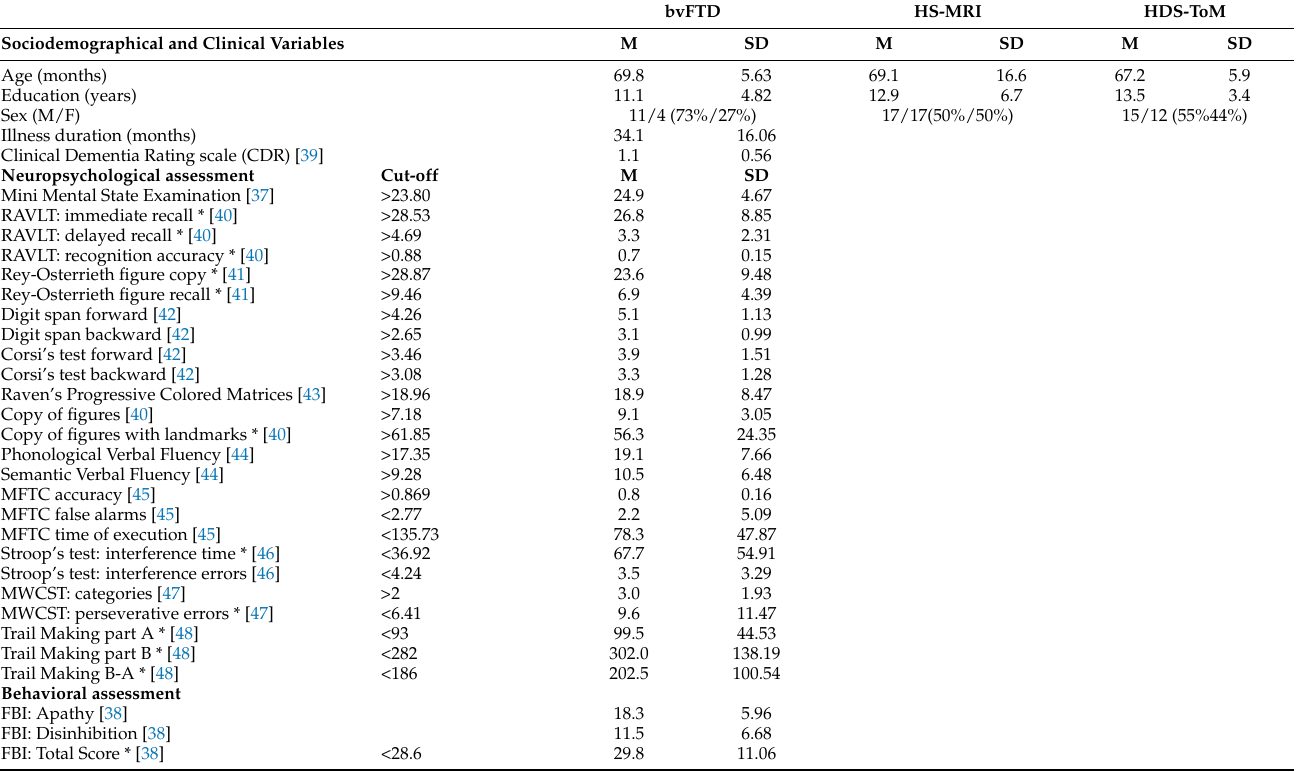
Table 1. Sociodemographic, clinical, neuropsychological, and behavioral features of the bvFTD sample.